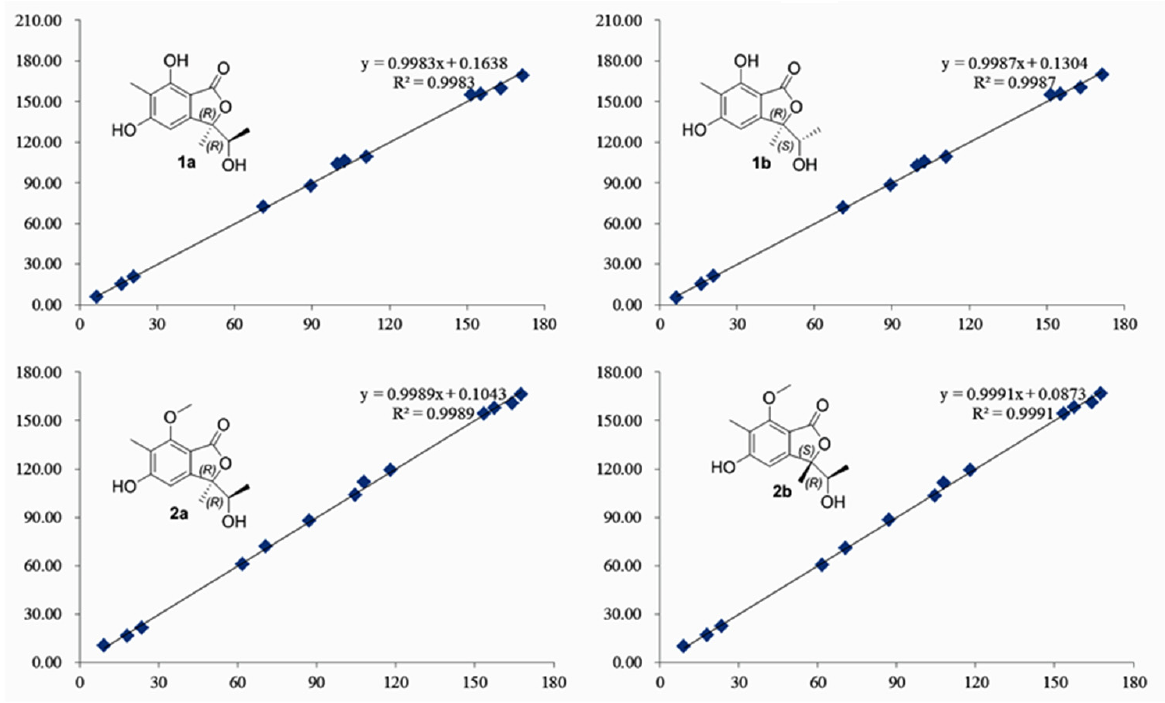
Figure 3. Regression analysis of experimental and calculated 13 C NMR chemical shifts for 1 and 2 .